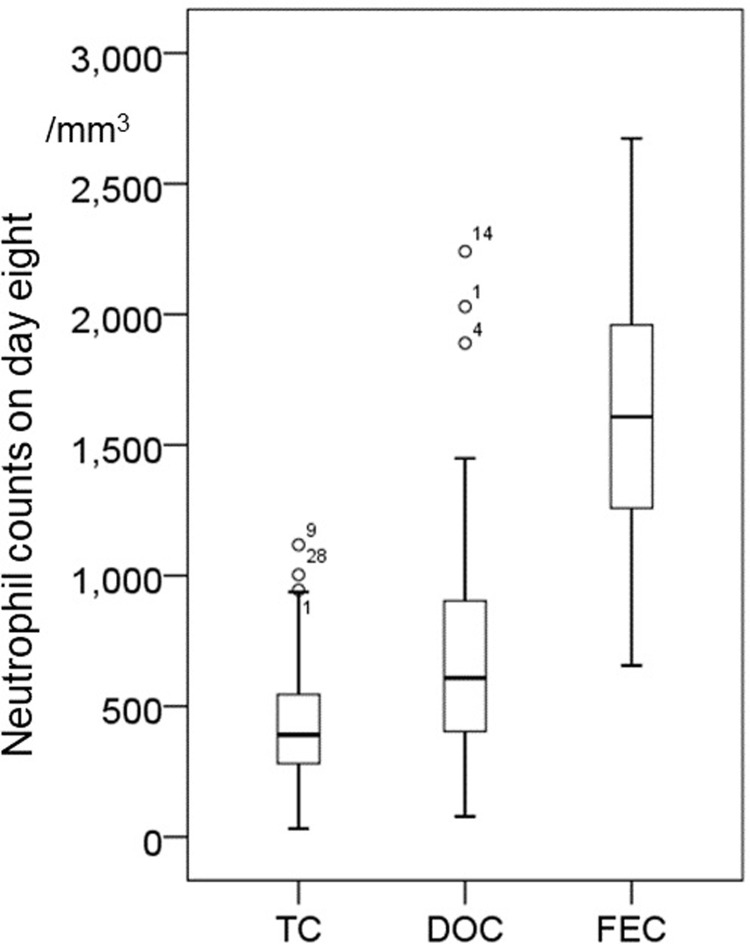
Absolute neutrophil count on day 8 in TC, DOC and FEC-treated patients.Box-plot diagram of absolute neutrophil count on day 8 in TC-treated, DOC-treated and FEC-treated patients.